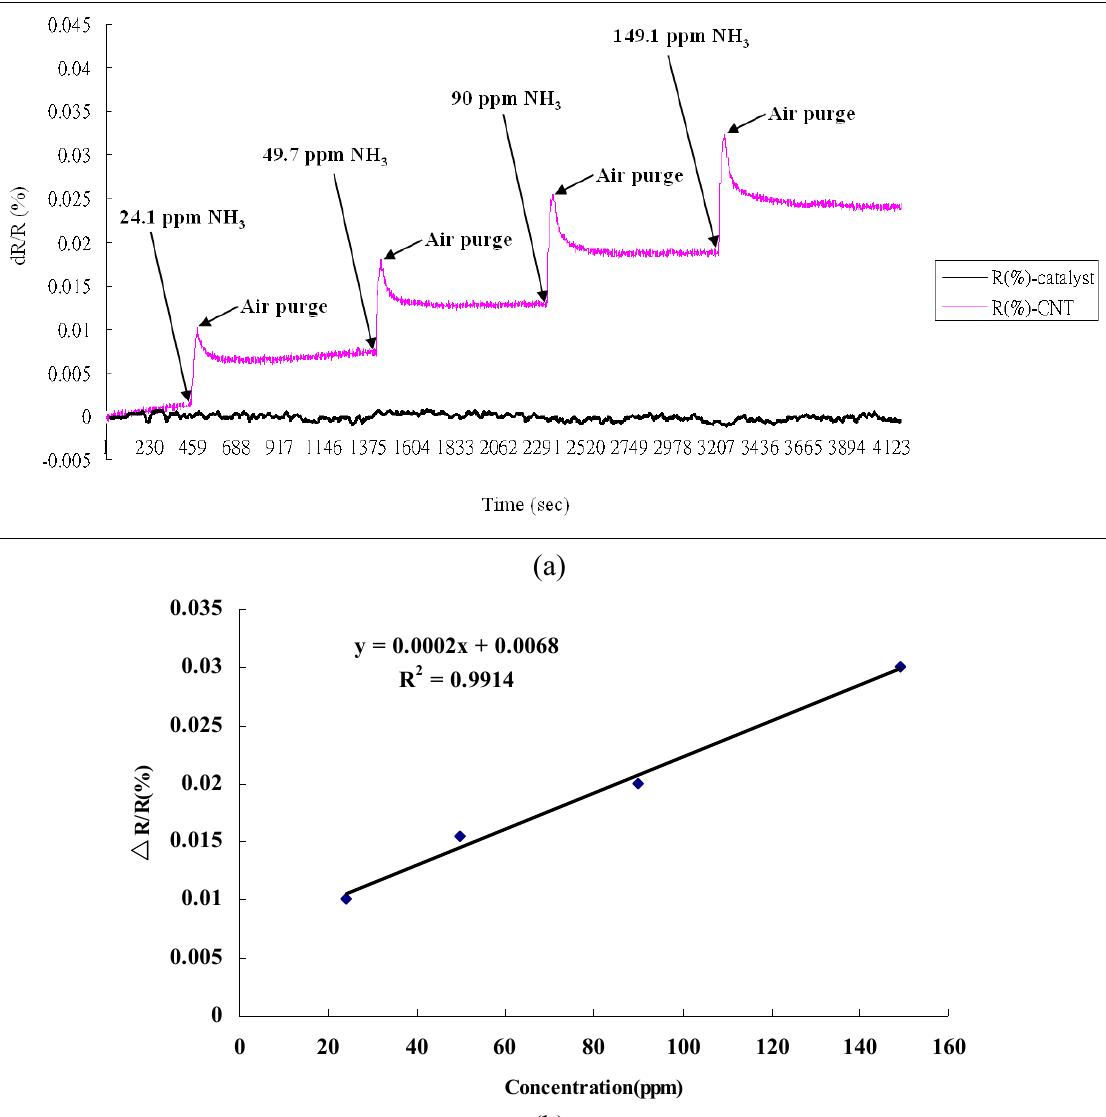
Figure 7. ( a ) The gas sensing devices with SWCNT network s (initial resistances: 65.372 k Ω ) and with only Fe catalyst on substrate responding to the NH and 149.1 ppm at room temperature, with a gate voltage set at zero, exhibited an increase in response R/ △ R (%) upon exposure to NH Figure